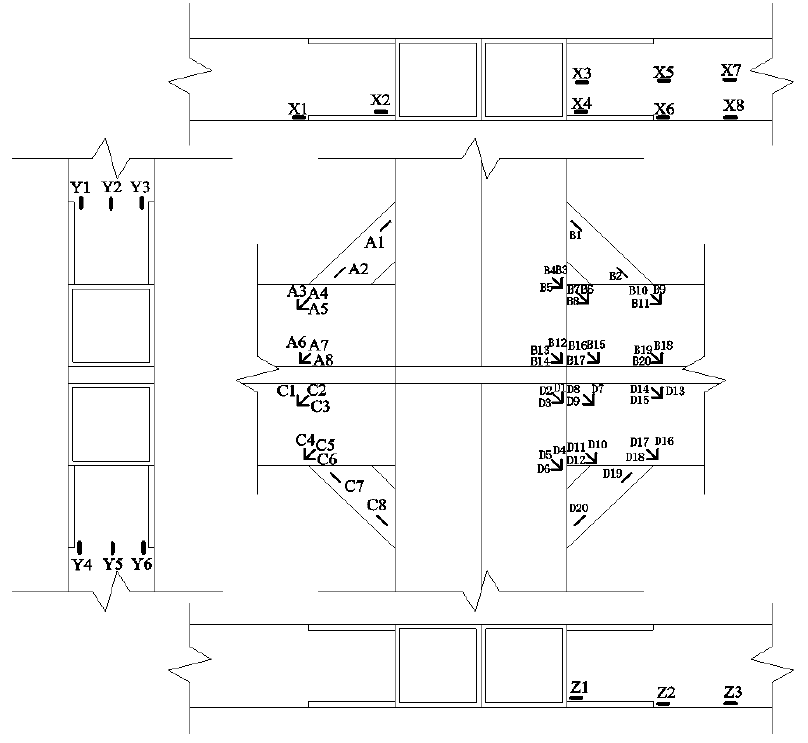
Figure 12. Strain gauge arrangement.